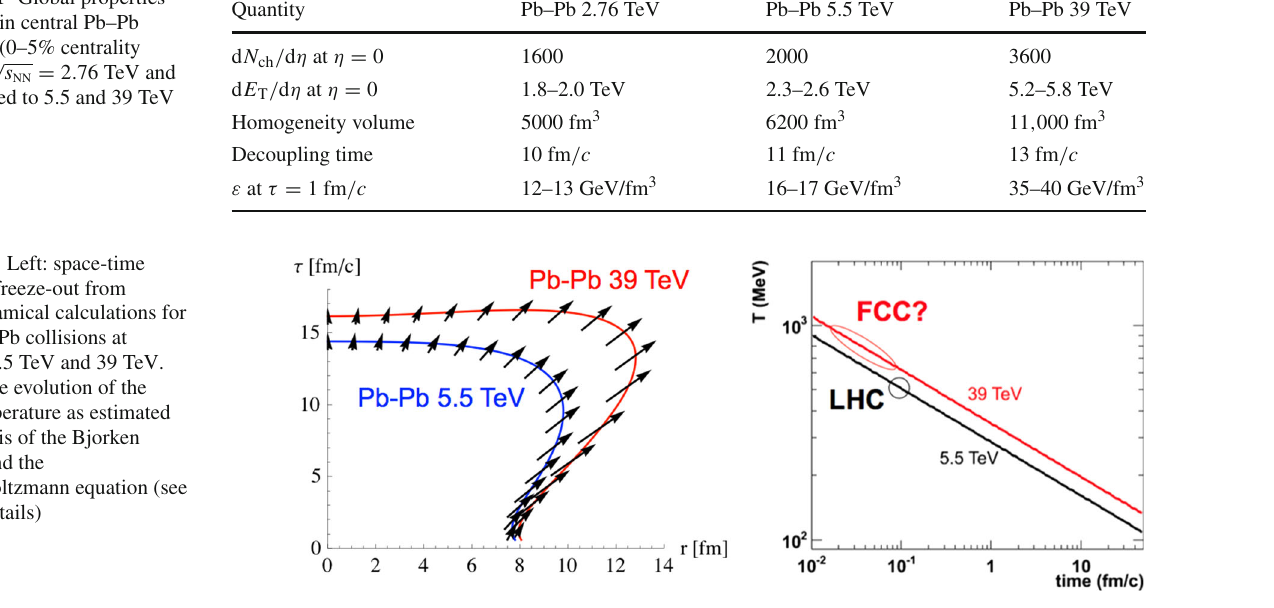
Table 16.1 Global properties measured in central Pb–Pb collisions (0–5% centrality √ = 2 . 76 TeV and s class) at NN